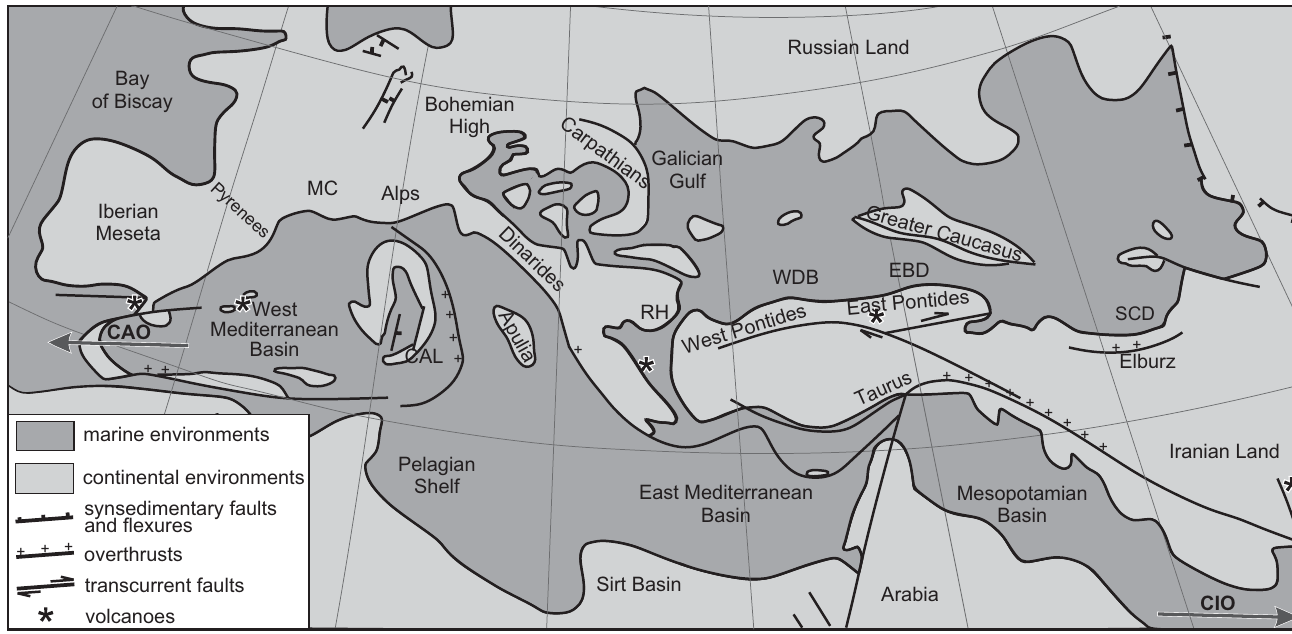
Fig. 1. Paleogeography of the Mediterranean area (Tethys and Paratethys Realms) during the late middle Miocene (12–11 Ma), simplified from Popov et al. (2003). CAO, connection with Atlantic Ocean; CAL, Calabria; CIO, connection with Indian Ocean; EBD, Eastern Black Sea Depression; MC, Massif Central; RH, Rhodope High; SCD, South Caspian Depression; WBD, Western Black Sea